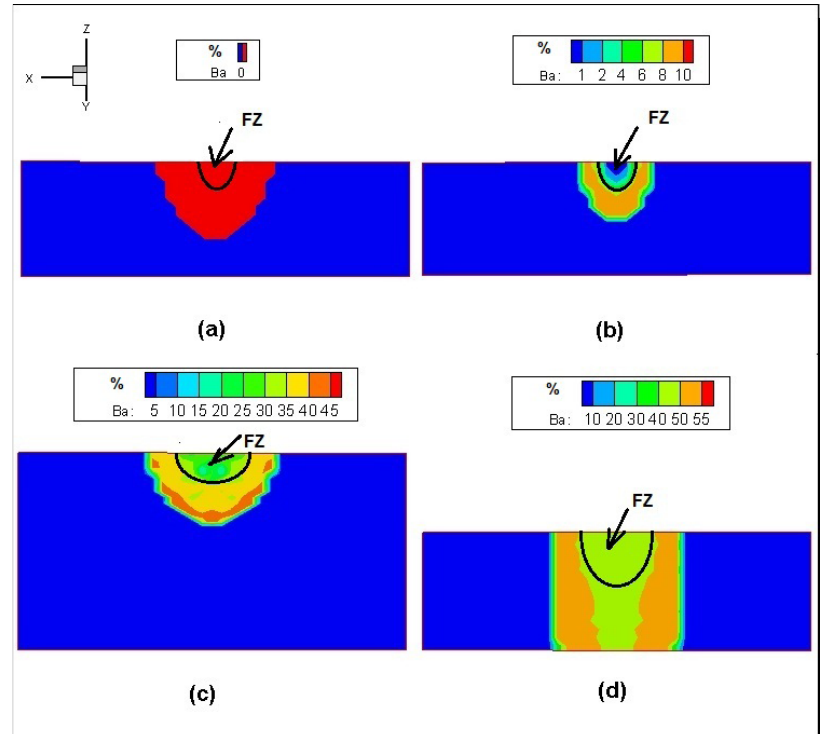
Figure 12 - Bainite distribution: (a) 0.5 kJ mm -1 (10 mm); (b) 0.5 kJ mm -1 (10 mm with preheating); (c) 3 kJ mm -1 (25 mm) and (d) 3 kJ mm -1 (10